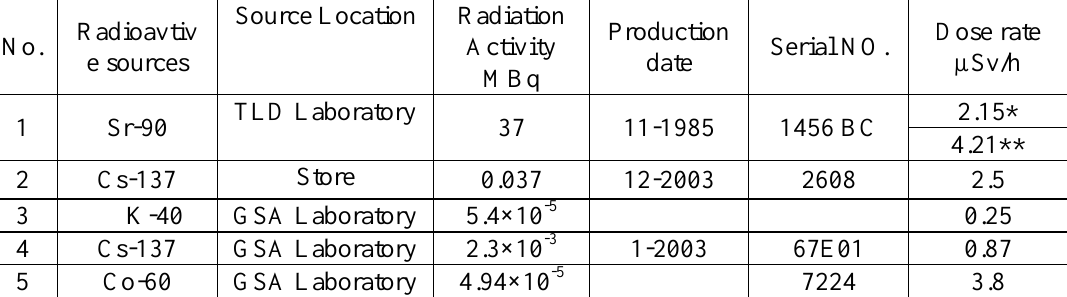
Table 1: The data taken by FAG portable